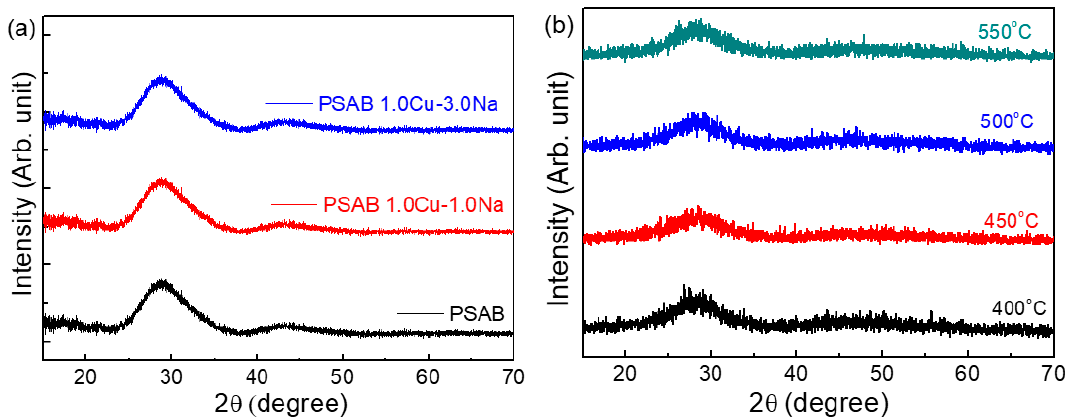
Figure 7. ( a ) XRD spectra for base PSAB system, 1 wt% CuO-doped, and 1 wt% CuO and 2 wt% Na 2 CO 3 codoped PSAB glass systems; ( b ) XRD spectra for codoped PSAB glass system sintered at 400 – 550 °C.